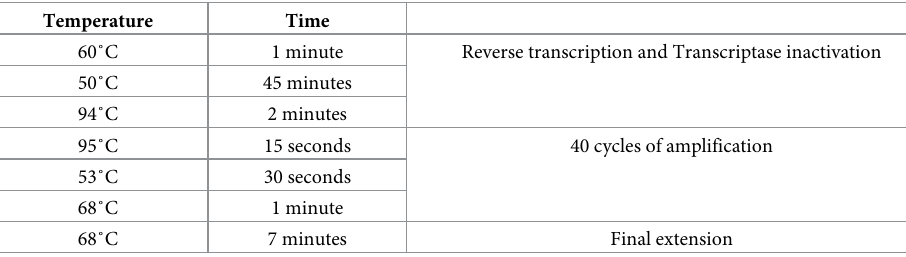
Table 3. RT-PCR cycle